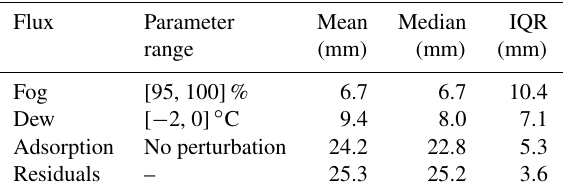
Table 2. Uncertainty related to the flux partitioning parameters. The table summarizes the annual mean and median fluxes of all lysime- ters across all combinations of parameters in the given ranges. Ad- ditionally, their interquartile range (IQR) is